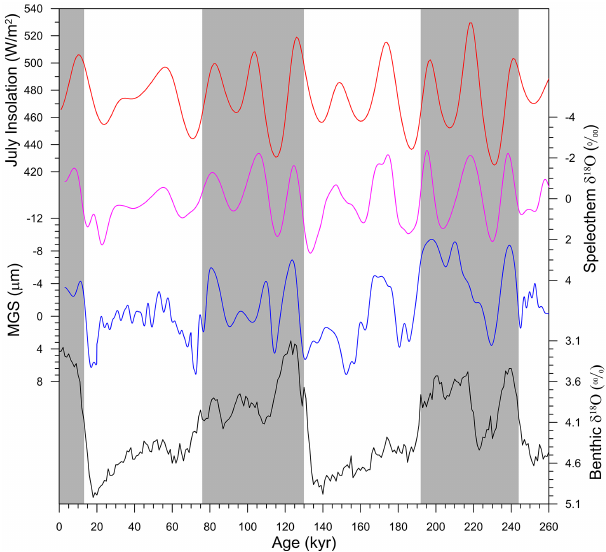
Figure 6. Comparison of the glacial- and orbital-scale components of Gulang MGS (blue) and Sanbao/Hulu speleothem δ 18 O (ma- genta; Wang et al., 2008; Cheng et al., 2009) records with sum- mer insolation at 65 ◦ N (red; Berger, 1978) and benthic δ 18 O record (black; Lisiecki and Raymo, 2005). The vertical gray bars represent the interglacial